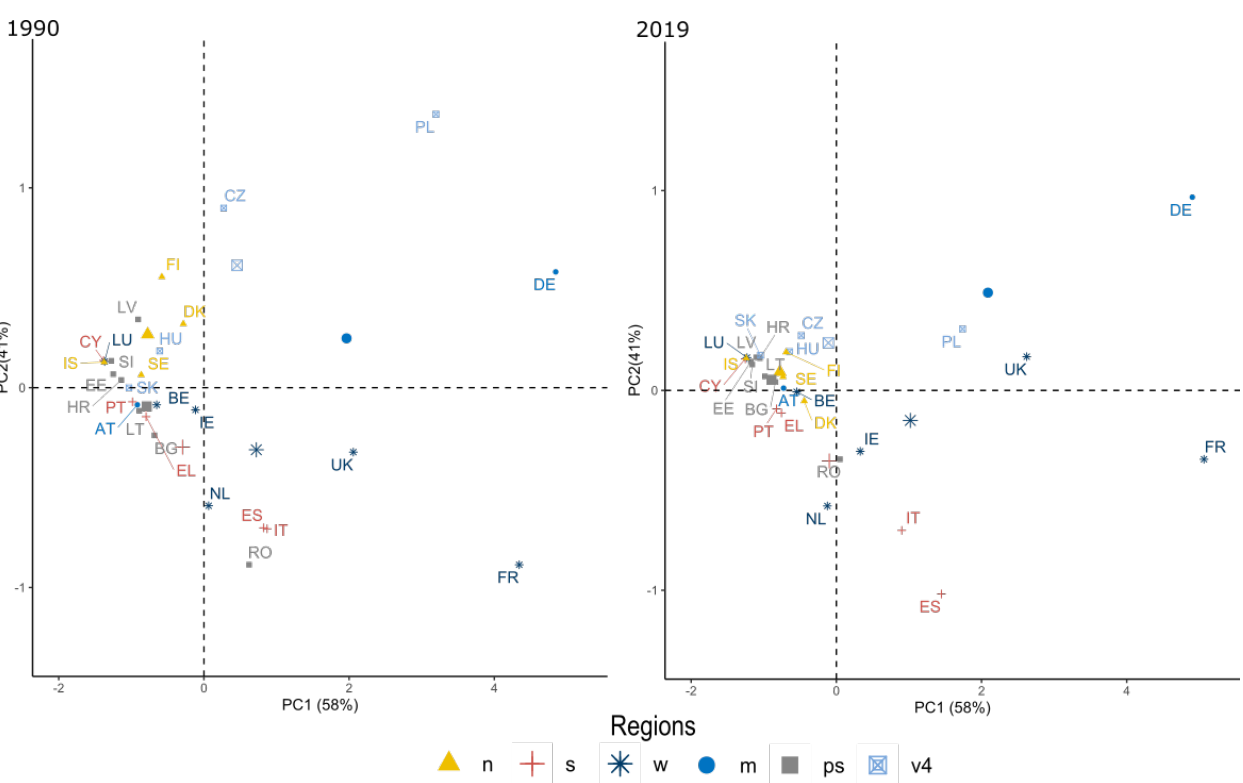
Figure 5. Ordination diagram of GHG emissions (N 2 O, CH 4 , CO 2 ) in 1990 and 2019 within EU-28 (agricultural sector; n: Northern Europe, s: Southern Europe, w: Western Europe, m: Middle Europe, ps: post-socialist countries, v4: Visegrad 4 countries; large symbols: group centroids).